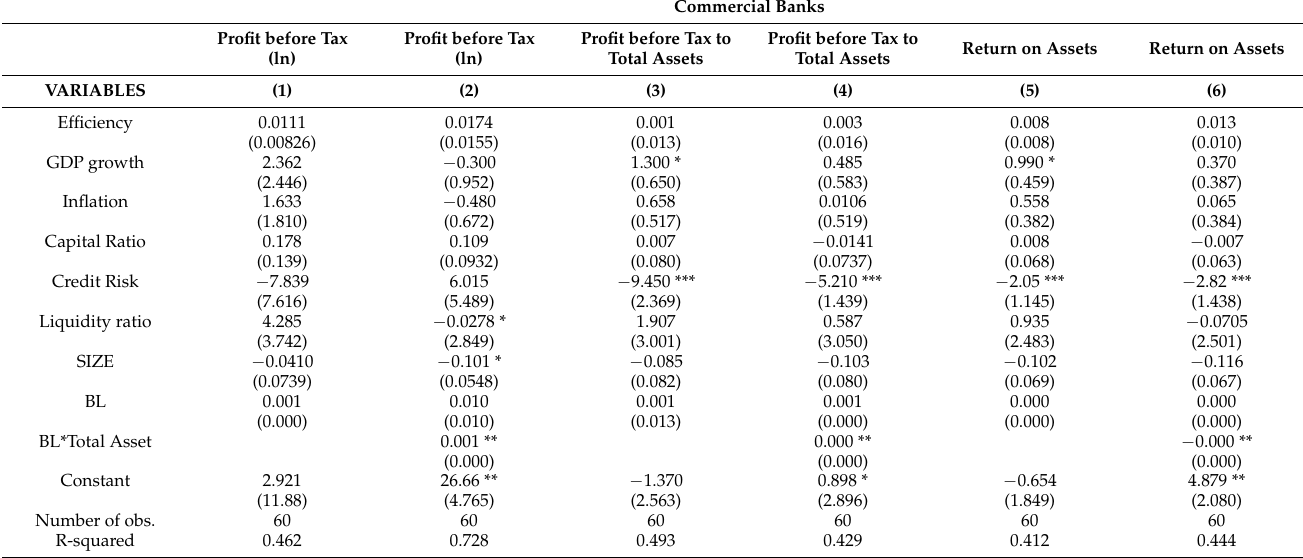
Table 3. Data presenting estimates based on GLS regressions with a random effect on Hungarian commercial banks. Symbols *, **, and *** represent statistical significance at the levels of 10%, 5%, and 1%,